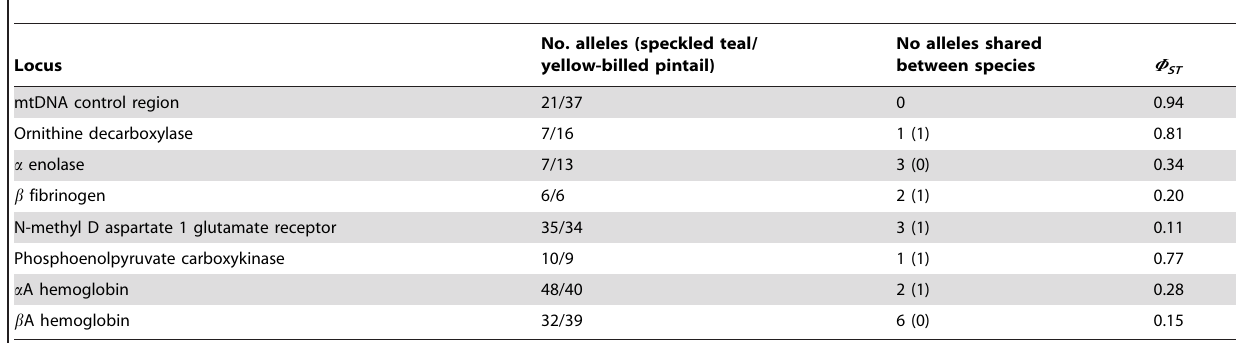
Table 3. Patterns of allele sharing and W ST between speckled teal and yellow-billed pintails.